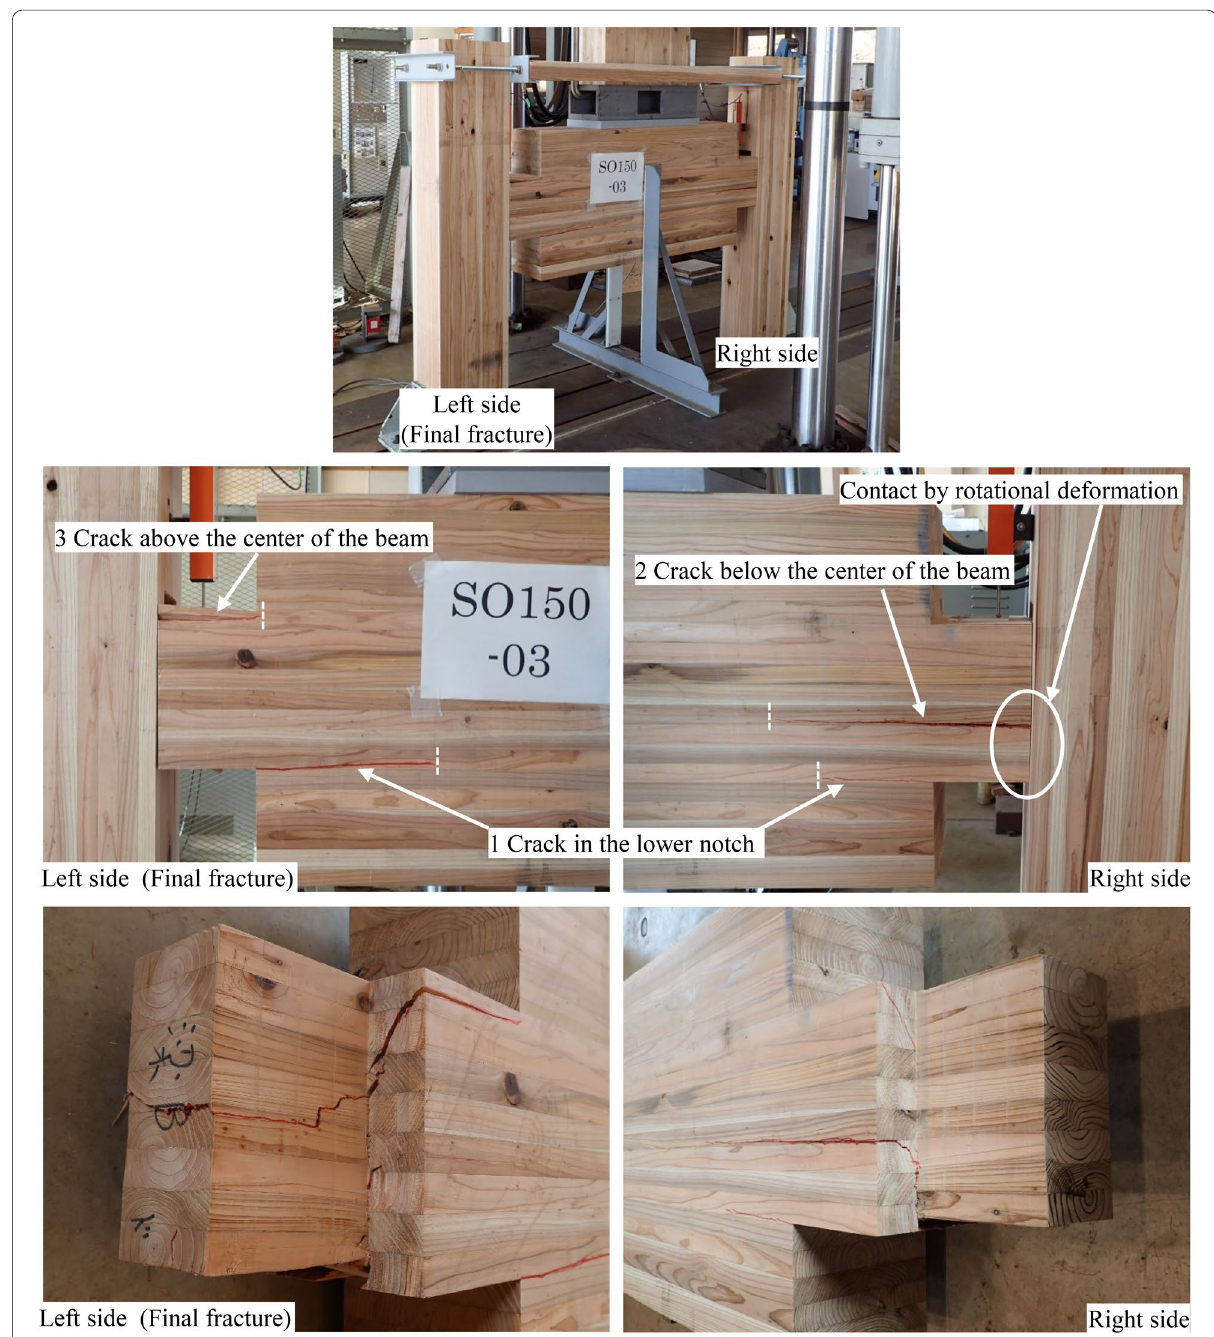
Fig. 15 Final fracture state of the specimen (J-L150, No.